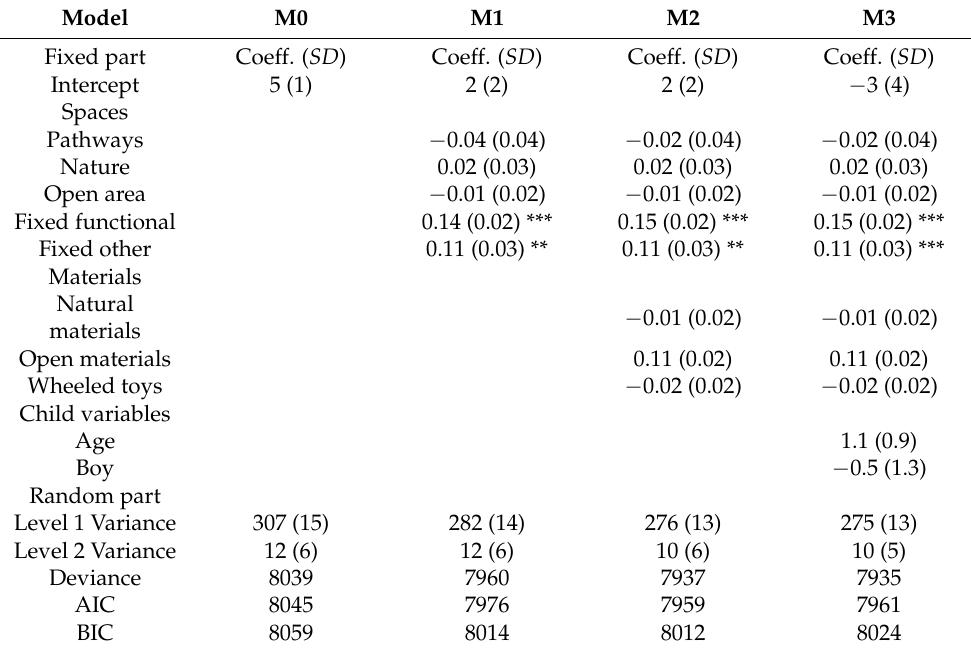
Table 4. Regression models for play in heights ( n = 935 observations).